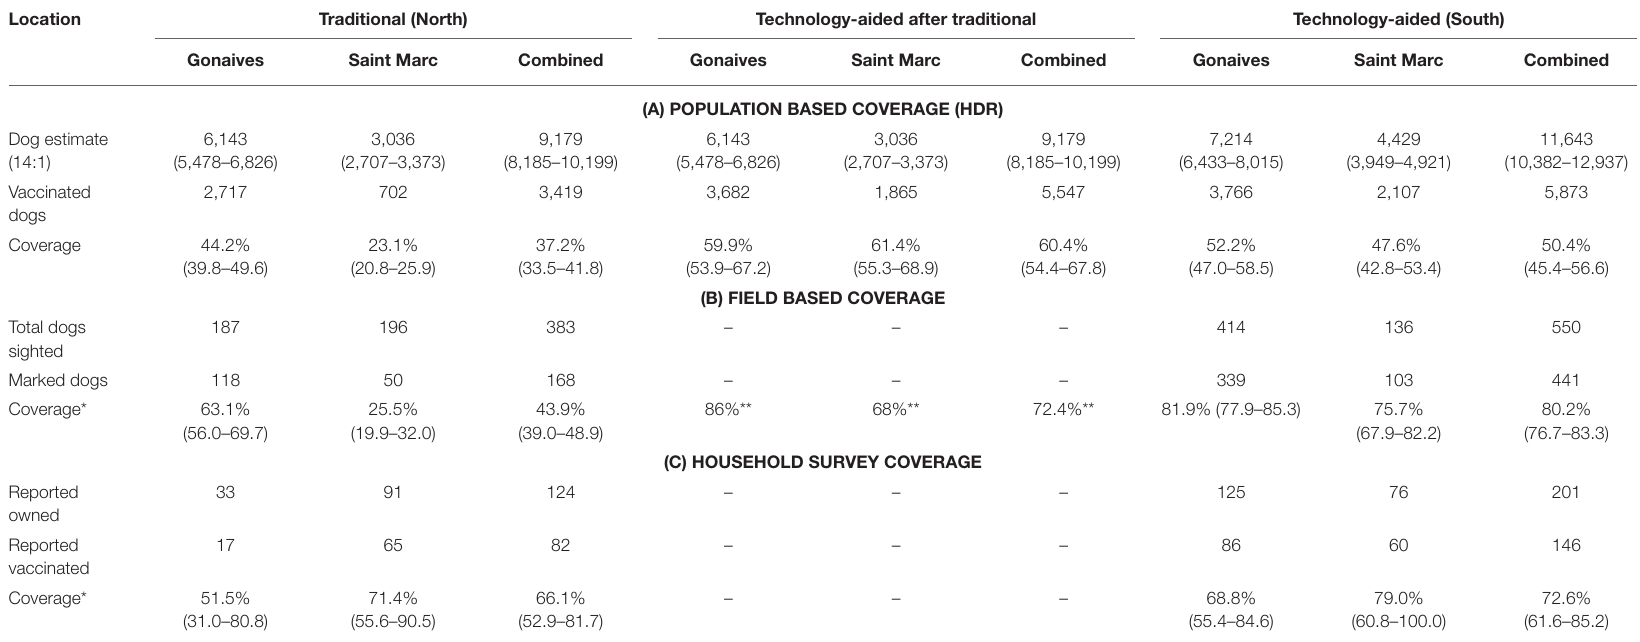
* Confidence intervals for field-based and household survey vaccination coverages were calculated using the Wilson Score corrected for population size. ** Coverage estimates were calculated based on the increase in number of dogs vaccinated during the Technology-aided-after-traditional method was conducted. Post-vaccination surveys were not conducted after this method was